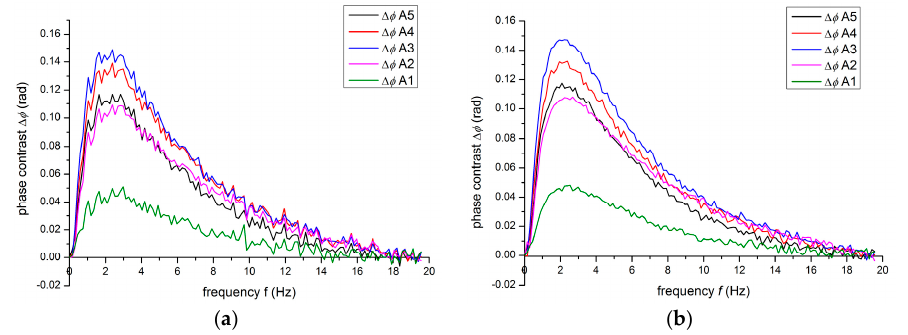
Figure 9. Phase contrast profiles of the Series A insertions (0.2 mm) after: ( a ) selecting the left top corner; and ( b ) the whole surface as a sound area.